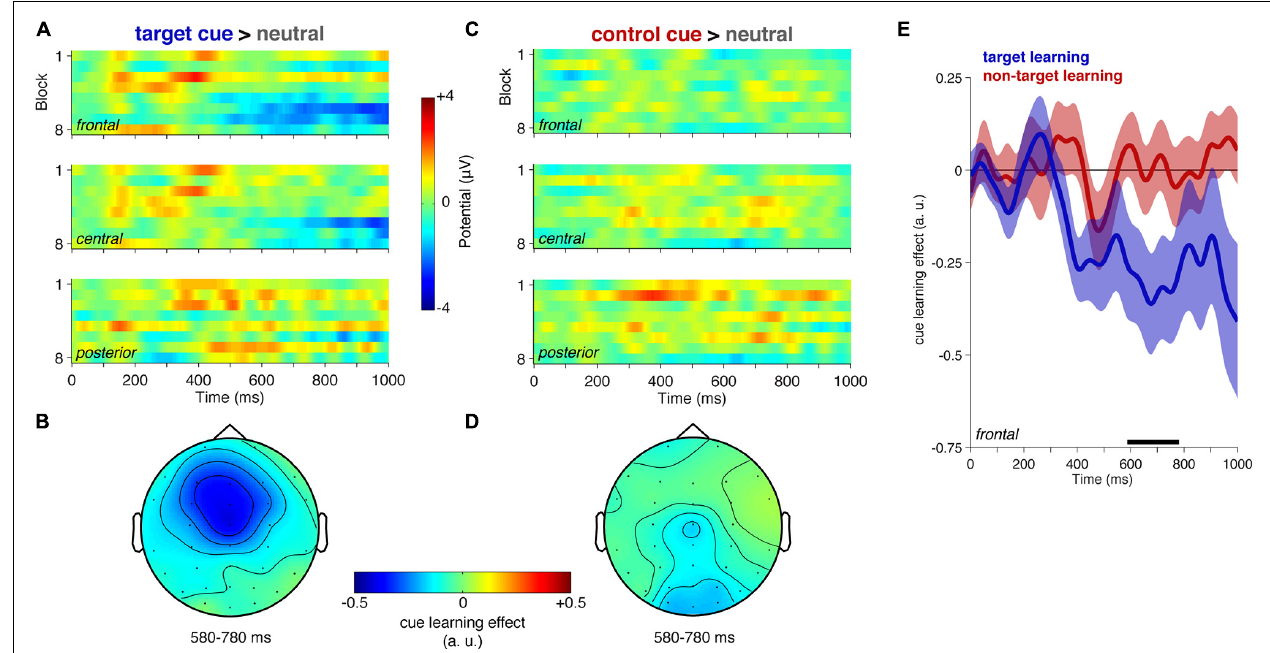
the same as (A) and (B) , but for the control cue. (E) The mean regression slope across the eight task blocks (fit separately at each time point) is shown for the frontal ROIs shown in (A) and (C) , for target cues (blue lines) and control cues (red lines). Shading indicates SEM. There was